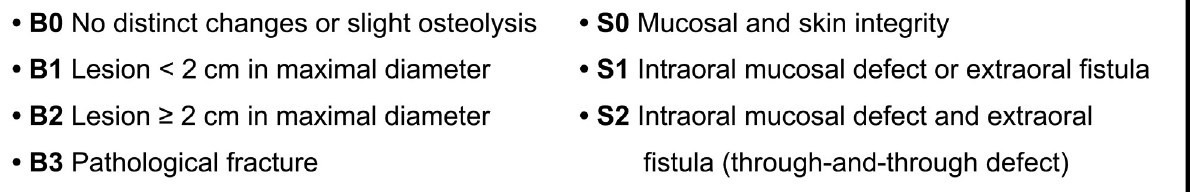
Figure 2- Classification of ORNJ based on clinical and imaging parameters